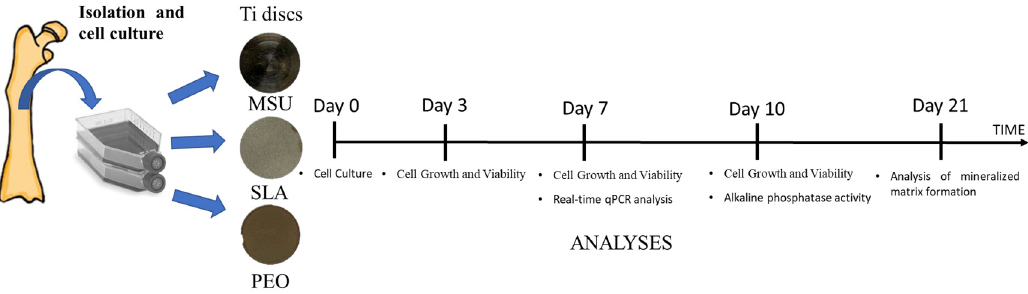
Figure 1. Schematic representation of the experimental groups and periods of the analyses.